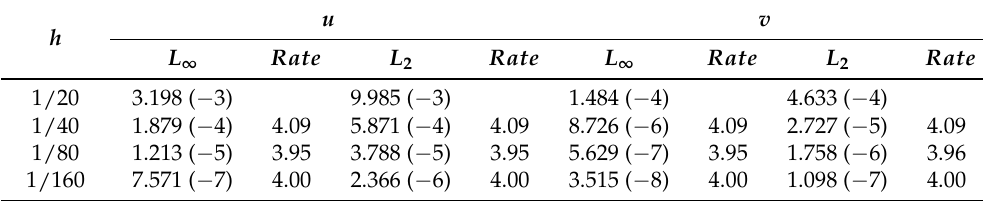
Table 5. The L ∞ error, L 2 error and convergence rate when a = s = 0.01, b = 0.1, d = 10 for Problem 3.